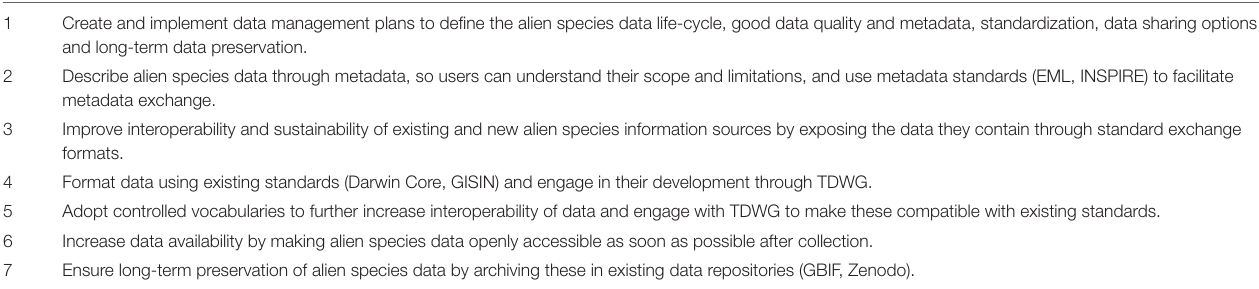
TABLE 2 | Seven recommendations for improving the usefulness of alien species